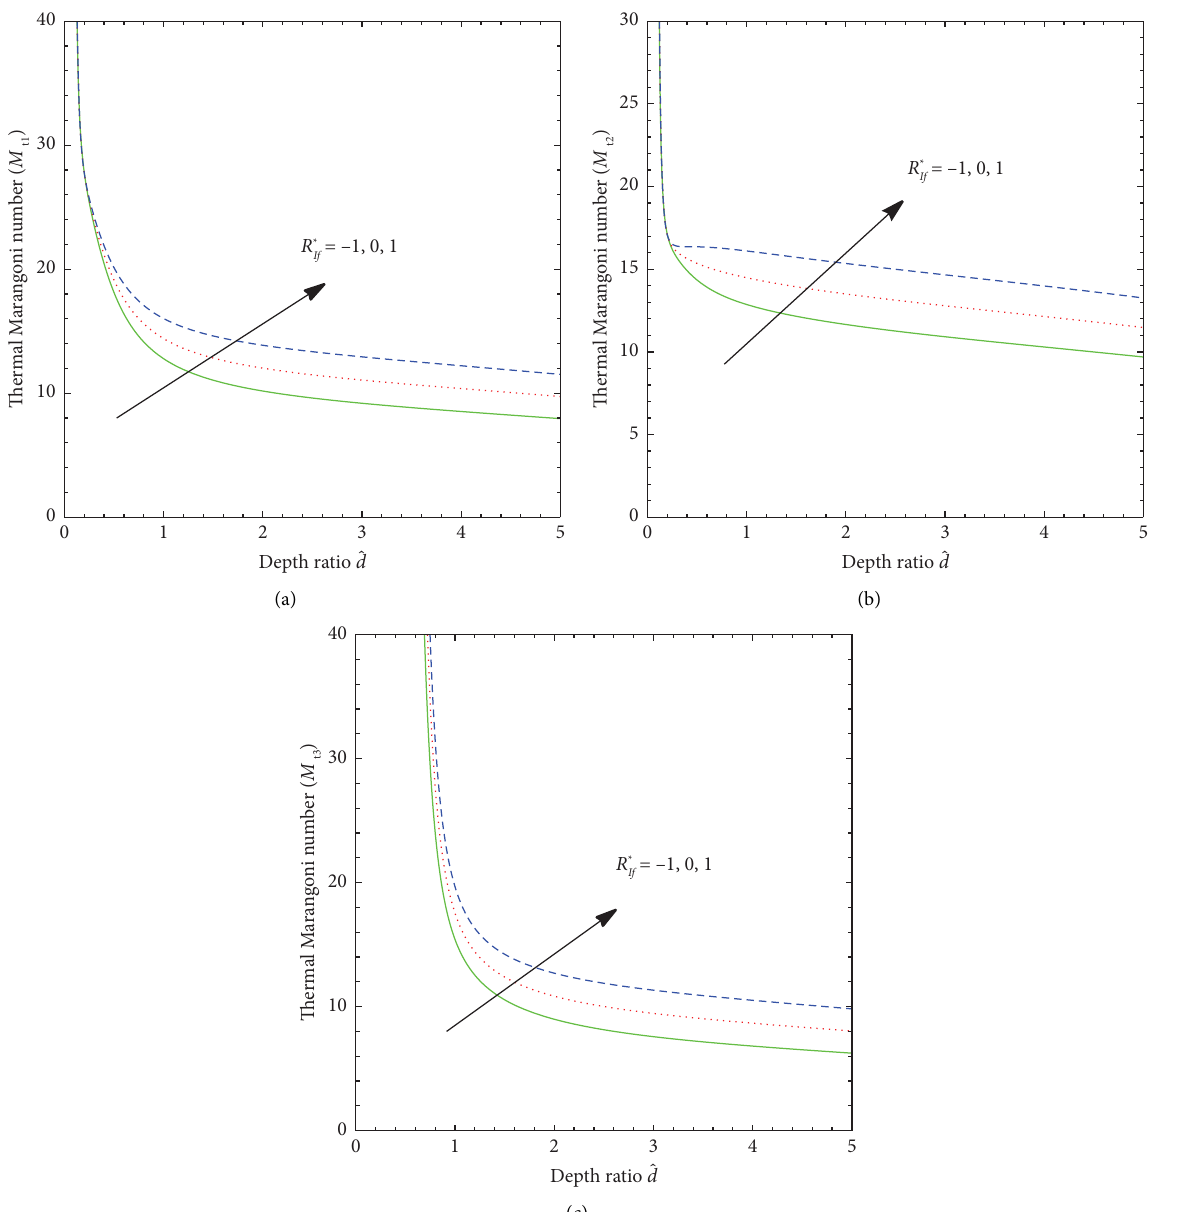
Figure 3: Efects of modifed Rayleigh number R ∗ τ f � τ p � 0 . 5 R ∗ Ip � 1, M S �